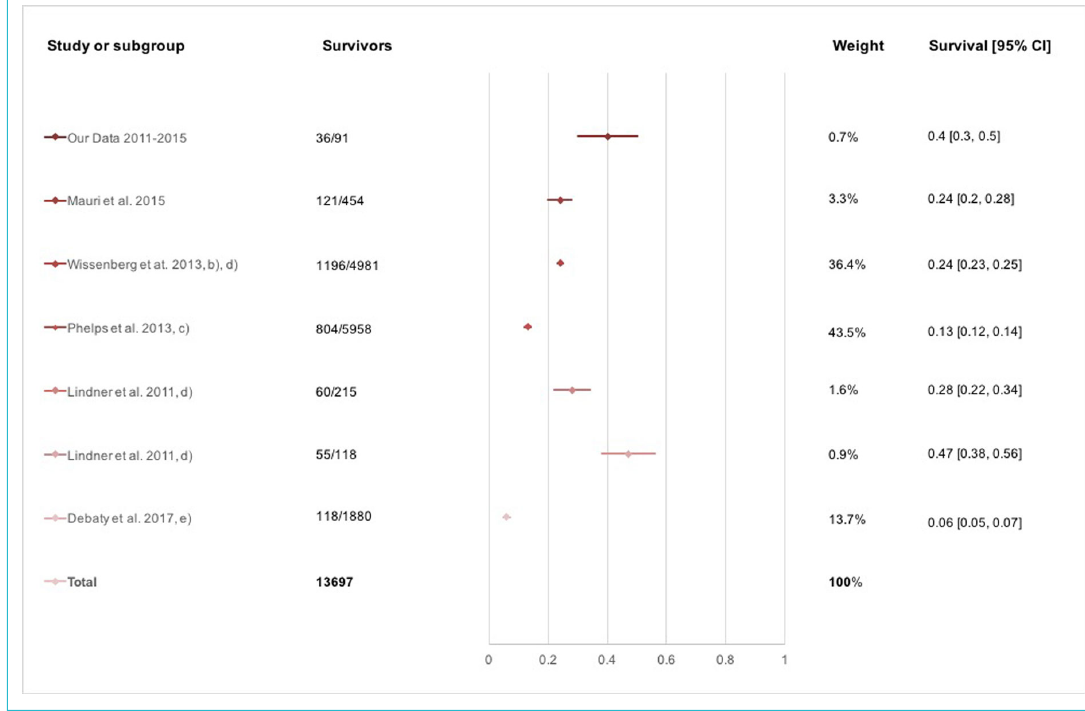
Figure 4: Survival at 1 year post-arrest.* Outcomes are reported according to Utstein (cardiac aetiology, witnessed [layperson or EMS] and shockable initial rhythm), if not mentioned otherwise: (a) at 30 days post-discharge; (b) excludes EMS-witnessed; (c) includes non-witnessed, non-shockable; d) includes non-witnessed; (e) includes non-cardiac, non-witnessed, non-shockable, excludes